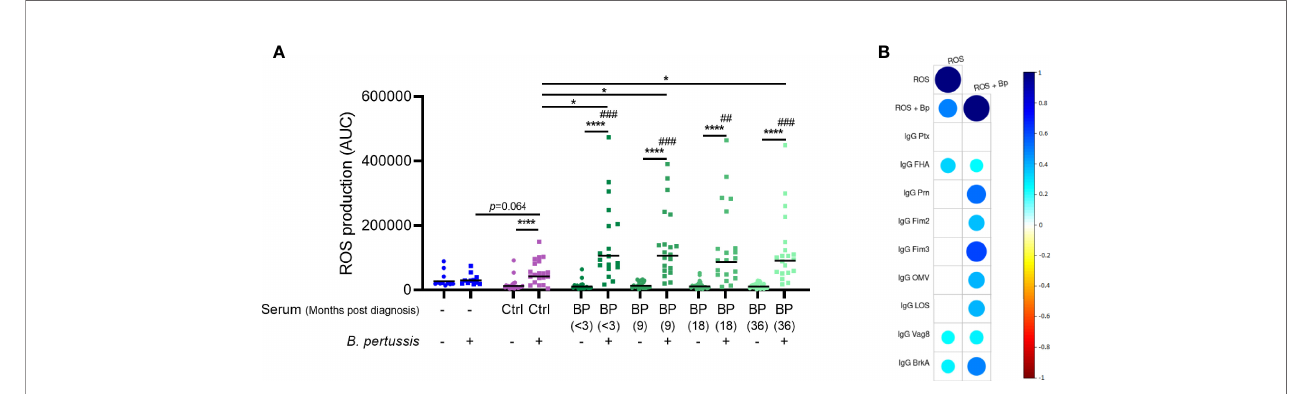
FIGURE 2 | Neutrophil ROS production induced by opsonized B. pertussis . (A) ROS production was measured in real-time for 30 minutes after incubation of neutrophils in the presence (squares) or absence (circles) of (opsonized) B. pertussis at MOI 10. Data is represented as individual AUC values with geometric mean. # indicate signi fi cance to “ No serum, No B. pertussis ” condition (blue circle). Ctrl (purple) indicates serum derived from healthy control individuals (n=21) and BP (green) indicate serum derived from convalescent pertussis patients (n=18 for timepoint <3 months, n=20 for remaining timepoints). *p <0.05, ## p < 0.01, ### p < 0.001, ****p < 0.0001. (B) Spearman correlations plots were performed between neutrophil ROS production at all time points and the levels of nine different antigen- speci fi c IgG antibody levels in plasma of the same convalescent pertussis patients. The ROS production was measured after incubating neutrophils with Bp-serum only (ROS) or with B. pertussis opsonized with BP-serum (ROS + Bp). Circles indicate a correlation with adjusted p < 0.05 and circle colors and size indicate the correlation r s